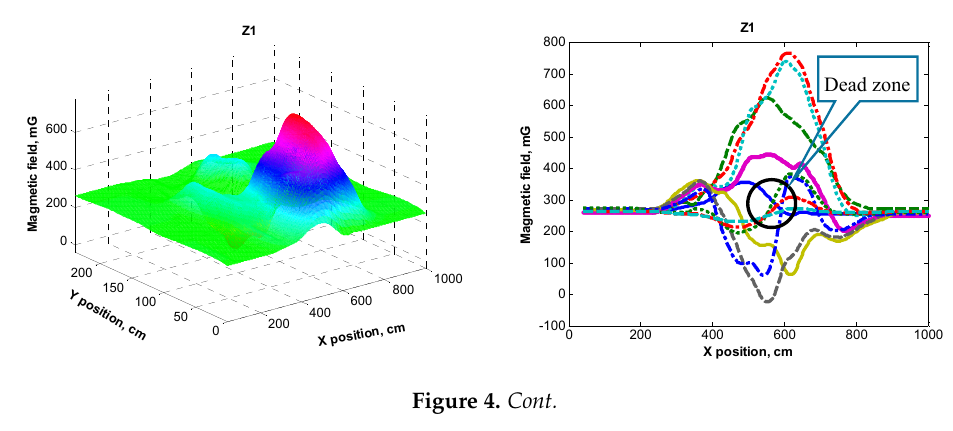
Figure 4. Figure 4 . Cont . Figure 4 . Cont .